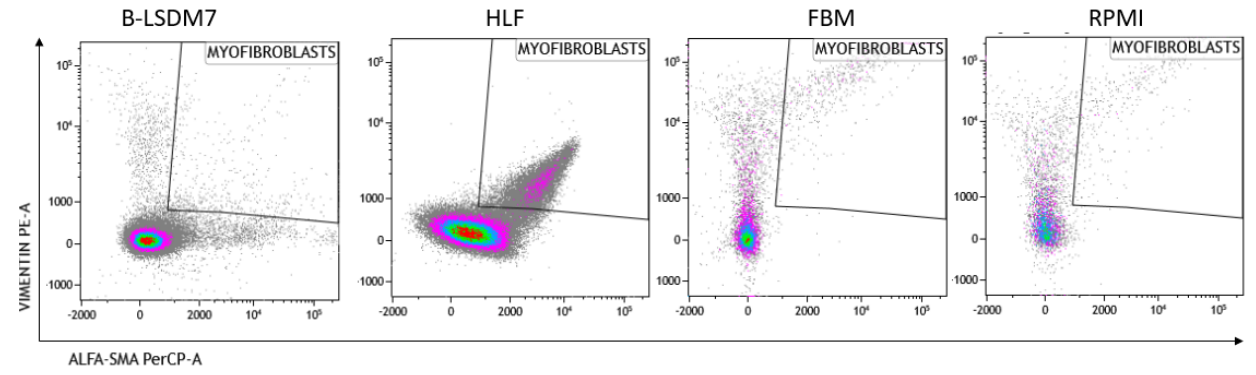
Figure 6. The Flow cytometric analysis of CD105, Fibronectin and Collagen Type 1 in B-LSDM7, HLF, FBM and RPMI cell lines.